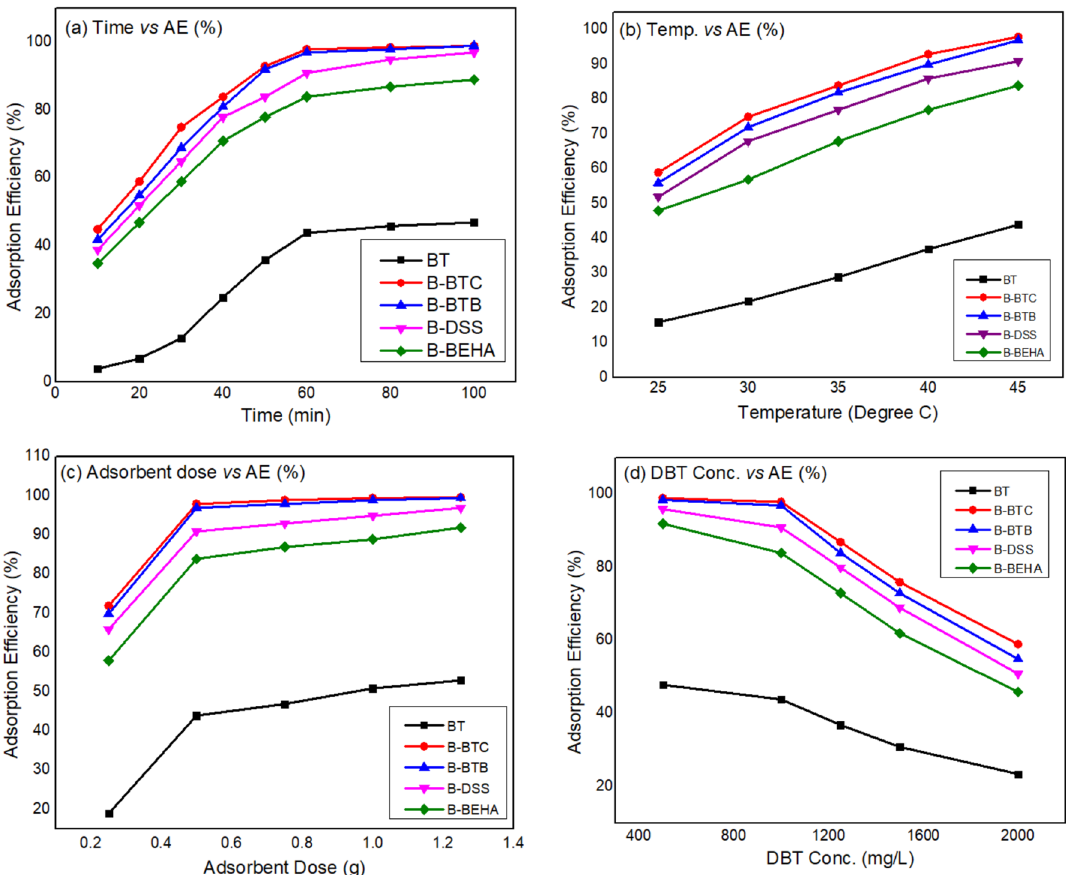
Figure 5. Effect of various parameters: time ( a ), temperature ( b ), adsorbent dose ( c ) and concentration ( d ) on the adsorption